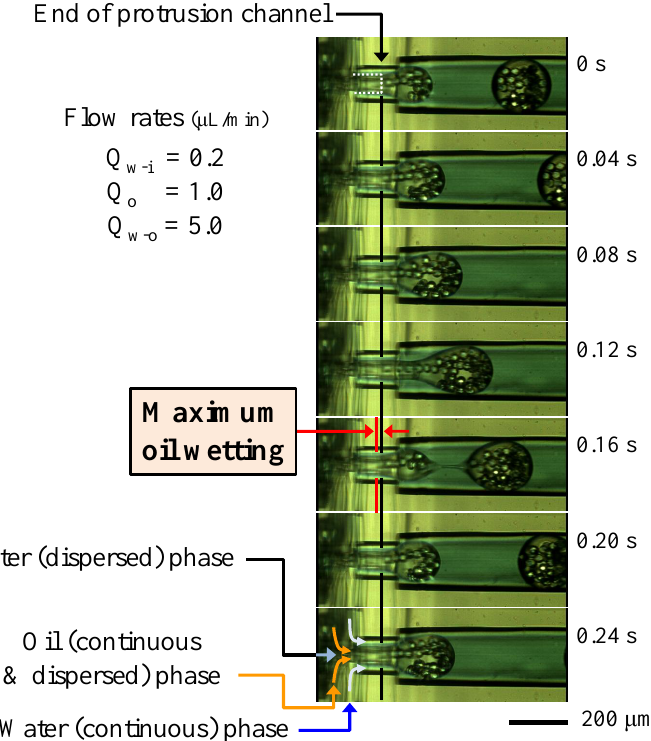
Figure 7. Visualization of the double layer (Water-in-Oil-in-Water (W/O/W)) droplet formation at the protrusion